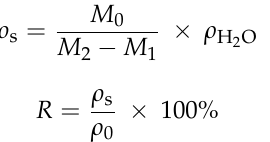
Figure 3. Printing directions and specimen layout.